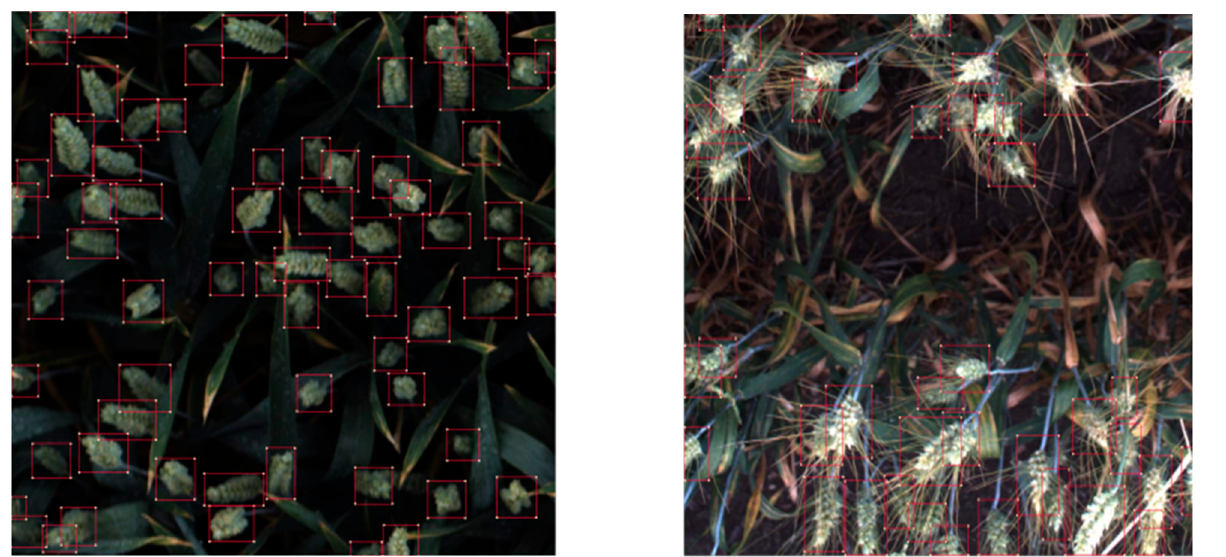
Figure 1. Samples of the wheat ears from the datasets. Table 1. Wheat related data.